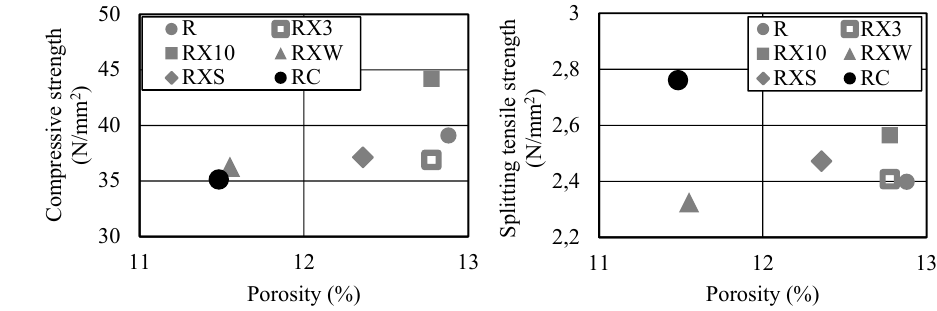
Figure 9. The relationship between porosity and strength.